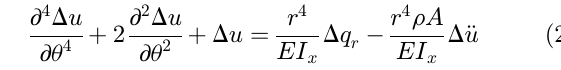
ffiffiffiffiffiffiffiffiffiffiffiffiffiffiffiffiffiffiffiffiffiffiffiffiffiffiffiffi (cid:1) 1 þ